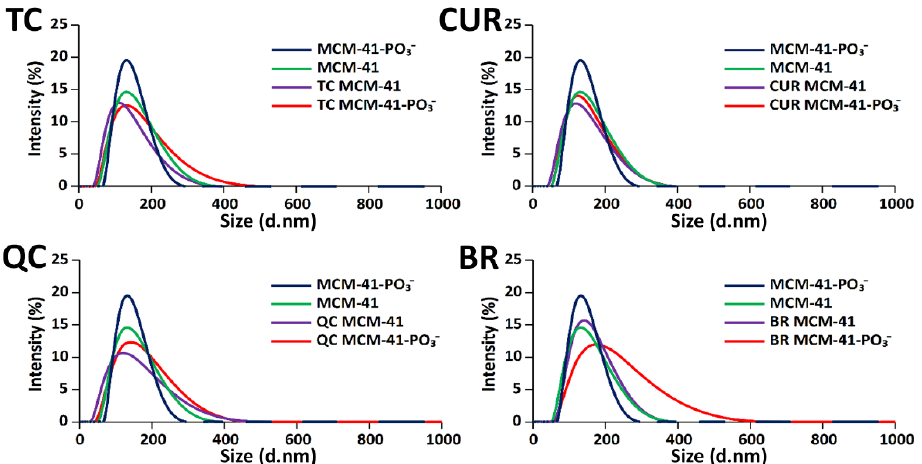
Figure 1. DLS intensity plots of hydrodynamic diameter measurements for SrtAI-loaded and non- loaded MCM-41 and MCM-41-PO 3 − MSNs.